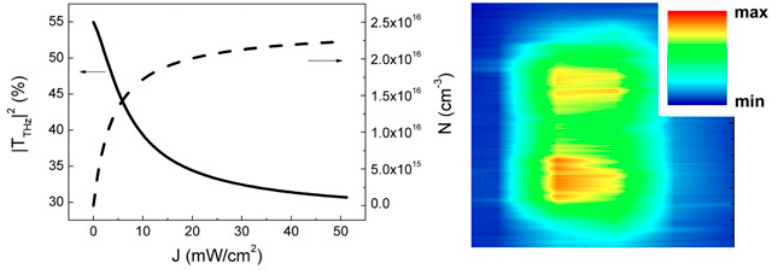
Figure 12. THz-QCL OF imaging of photogenerated carrier density distribution in n-doped Si (right, actual image is 1.6 × 1.6 mm 2 ). Left panel shows calculated THz transparency at the carrier density excited by a cw laser diode ( λ exc = 832 nm) (adapted from [45]).